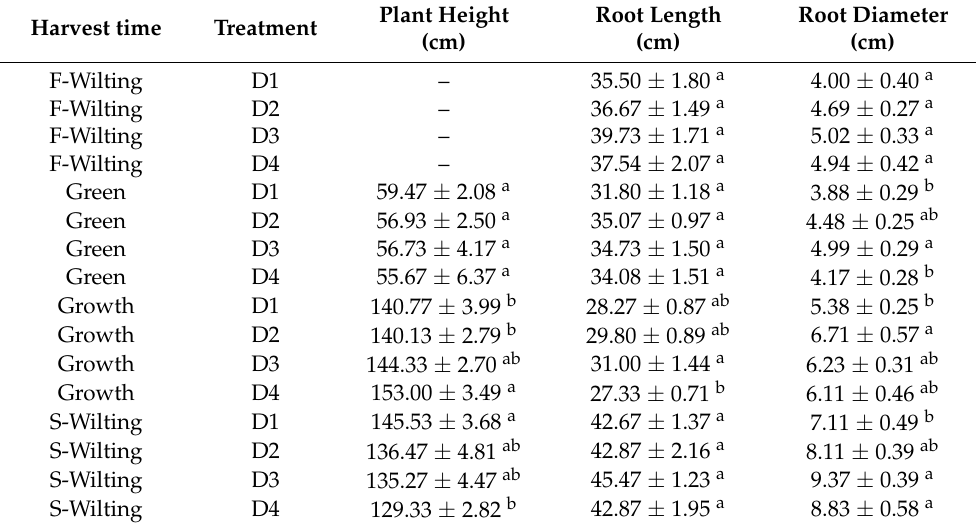
Table 1. Mean and standard deviation of growth and development indicators of A. tanguticus under the different density